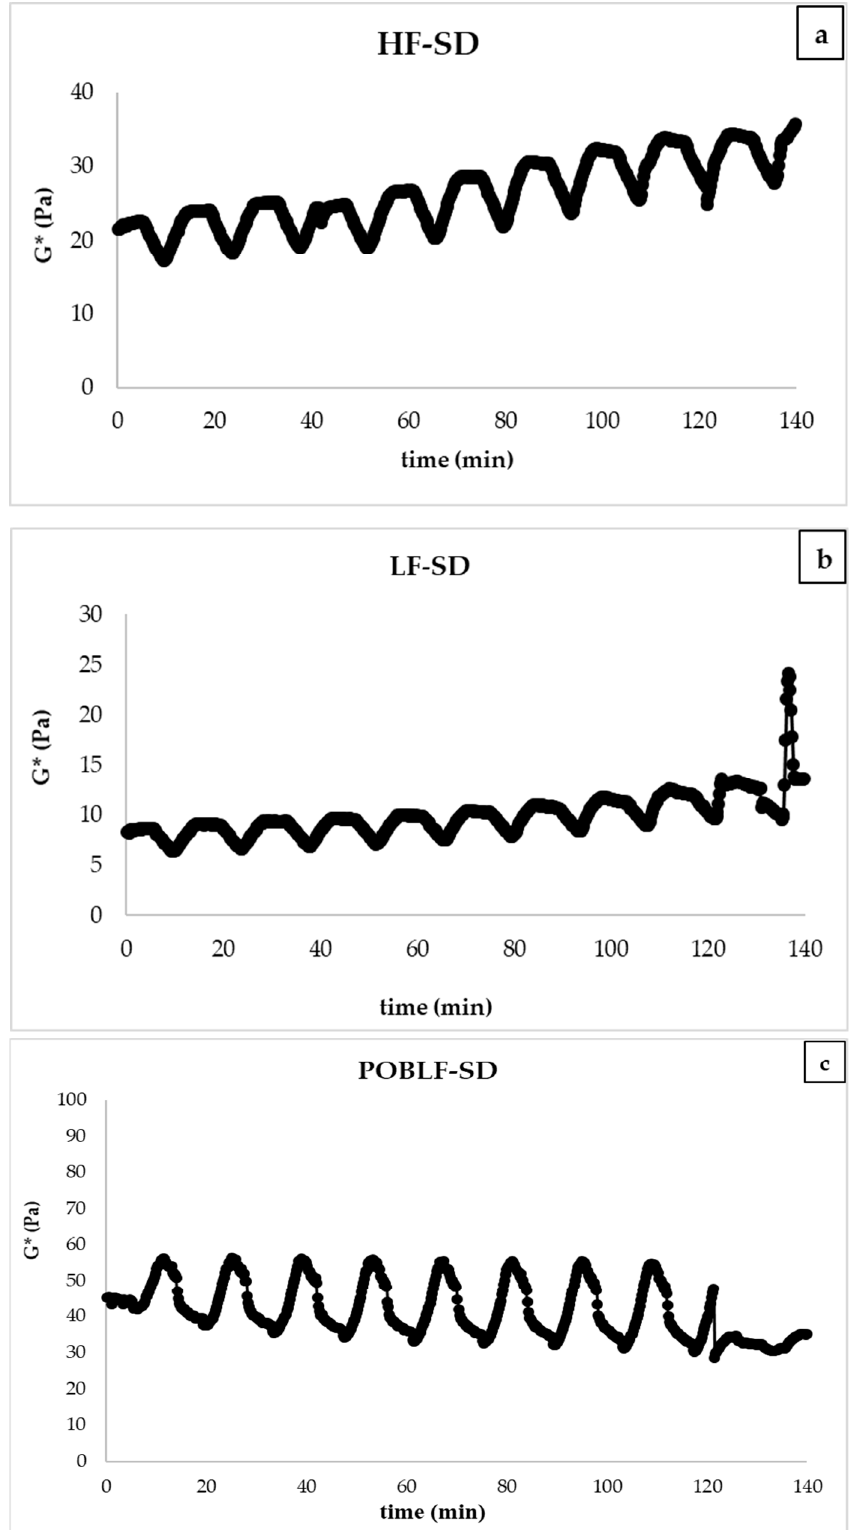
Figure 6. The change in G* value after applying the thermal loop (HF-SD: high-fat salad dressing sample; LF-SD: low-fat salad dressing sample; POBLF-SD: low-fat salad dressing sample with cold- pressed pumpkin seed oil by-product; G* (Pa): complex modulus). ( a ): thermal loop of HF-SD; ( b ): thermal loop of LF-SD; ( c ): thermal loop of POBLF-SD.